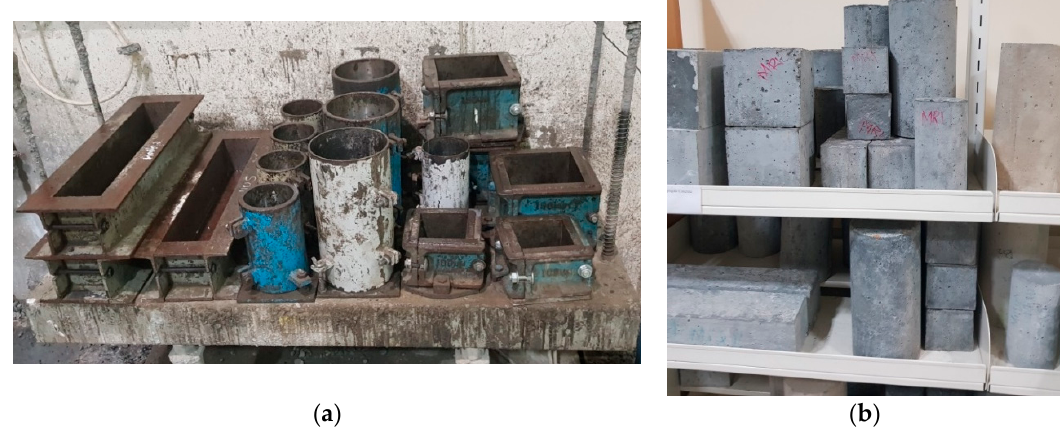
Figure 4. Samples preparation for mechanical properties. ( a ) Molds used for sample preparation, ( b ) Samples for mechanical evaluation.